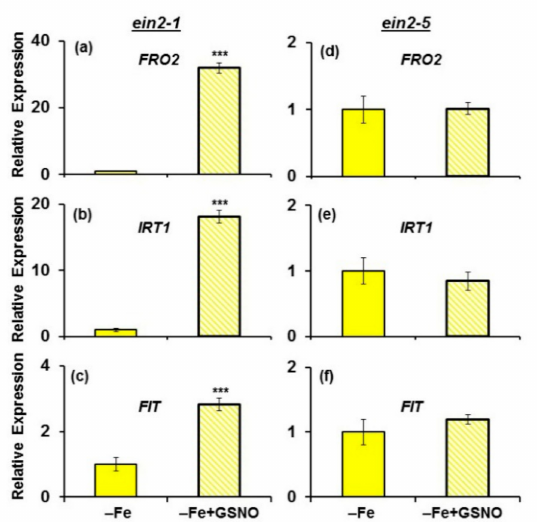
Figure 8. Effect of GSNO (NO donor) on FRO2 , IRT1 and FIT expression in roots of the Fe-deficient Arabidopsis ET insensitive mutants ein2-1 ( a – c ) and ein2-5 ( d – f ). Plants were grown in complete nutrient solution. When appropriate, they were transferred during 24 h to nutrient solution without Fe (–Fe). GSNO, at 100 µ M final concentration, was added to the nutrient solution of half of the plants. Determinations as in Figure 7. Bars with *** indicate significant differences ( p < 0.001) in relation to the –Fe treatment according to the Student’s test t